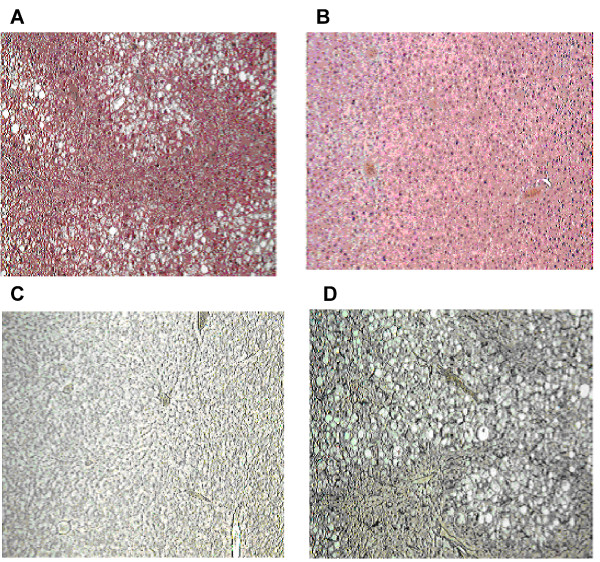
TGFβ1 overexpression induces severe liver fibrosis. A. Shown are representative micrographs following haematoxylin/eosin staining indicating severe liver fibrosis in TGFβ1 transgene expressing mice. B shows normal Tr- wild type mice liver tissue stained by haematoxylin/eosin. C. The deposition of the pro-collagen, reticulin, was also determined using specific monoclonal antibody anty-reticulin by immunohistochemistry in Tr- WT mice liver tissue sections. D. Whilst low abundance staining is seen in wild type liver, expression of reticulin is dramatically enhanced in the Tr+ TGFβ1 transgenic mice.